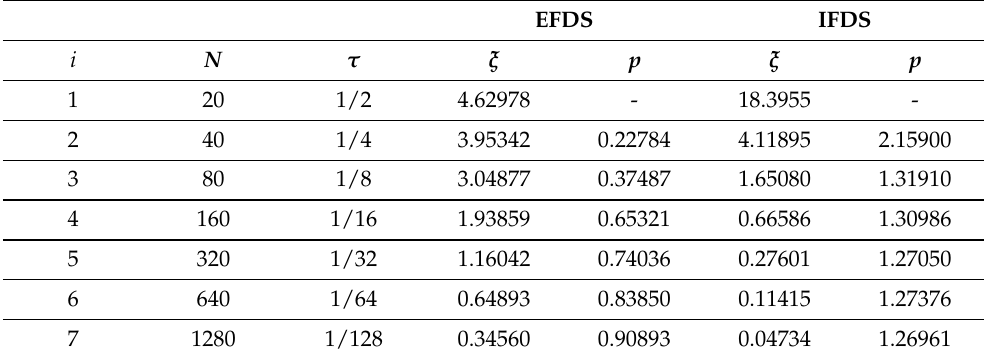
Table 4. Computational accuracy EFDS and IFDS, at T =